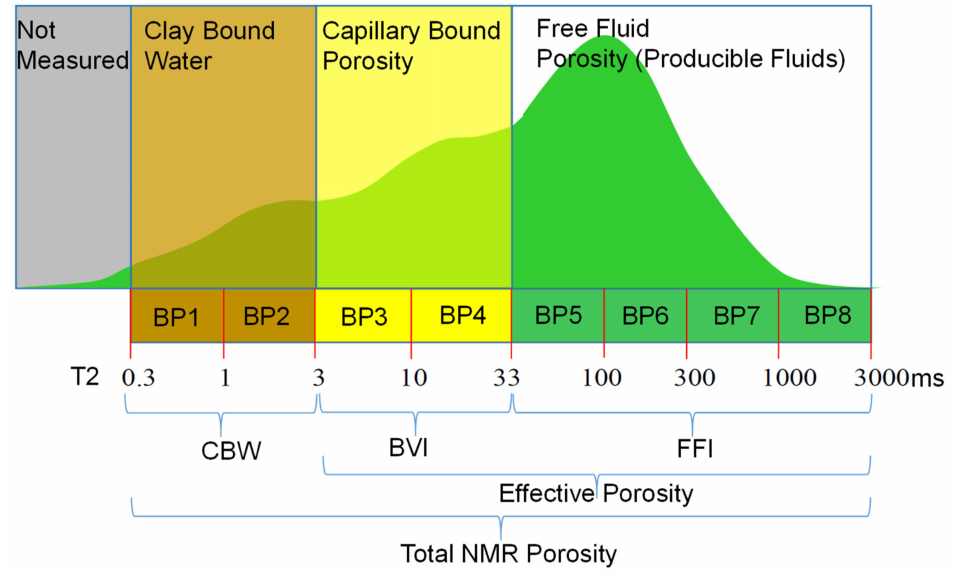
Figure 1. The T 2 distribution can be used with specified cutoffs to determine the total and effective porosity, clay bound water, capillary bound fluid, and free fluid. These properties are shown in relation to the T 2 signal. Note that the T 2 cutoff values of 3 msec and 33 msec are standard defaults for